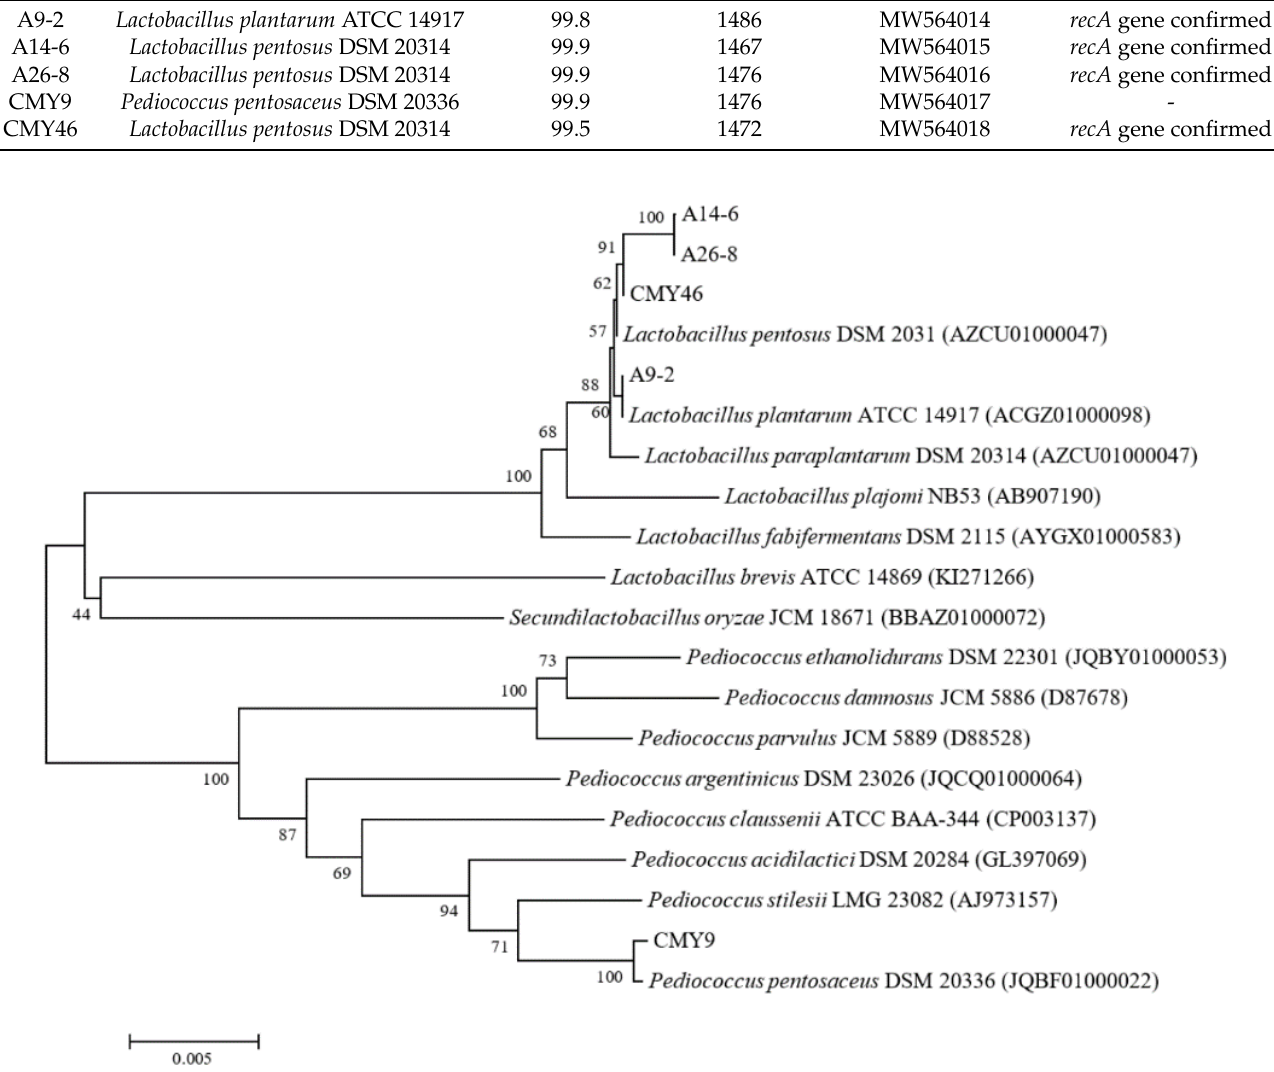
Table 2 . Molecular identification of LAB isolates by 16S rRNA gene sequence analysis.